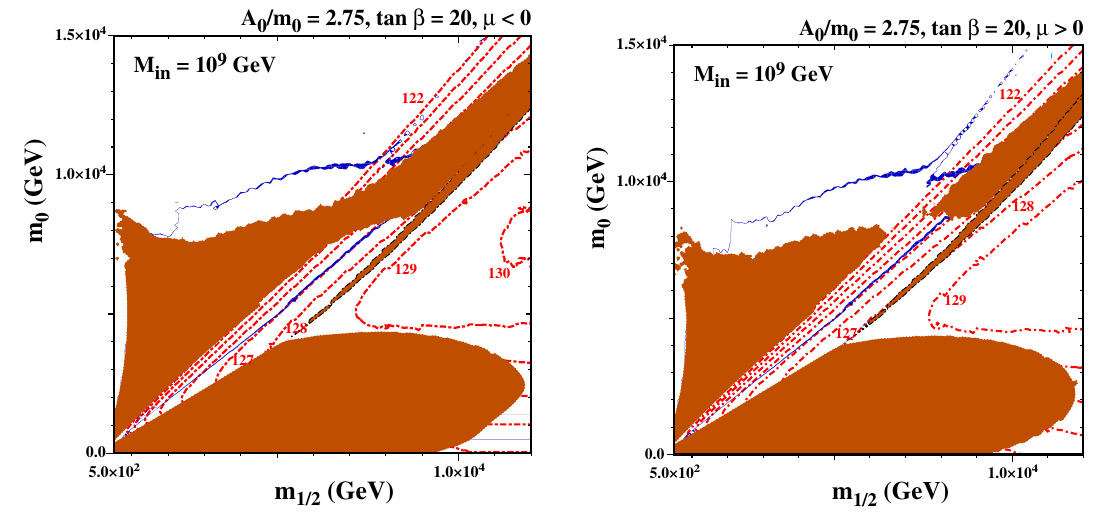
Fig. 6 The ( m 1 / 2 , m 0 ) planes in a sub-GUT model with M in = 10 9 GeV and tan β = 20. In the left panel, A 0 = 2 . 75 m 0 and μ < 0, whereas in the right panel A 0 = 2 . 75 m 0 and μ > 0. Strips with the allowed cosmological LSP density are shaded dark blue. In this figure